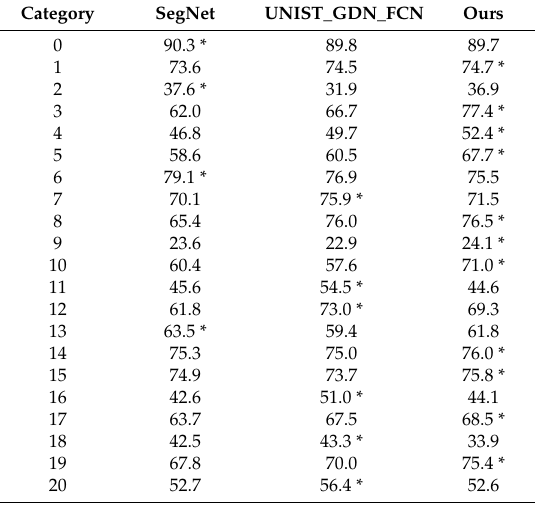
Table 2. The Intersection Over Union (IoU) scores of three methods.